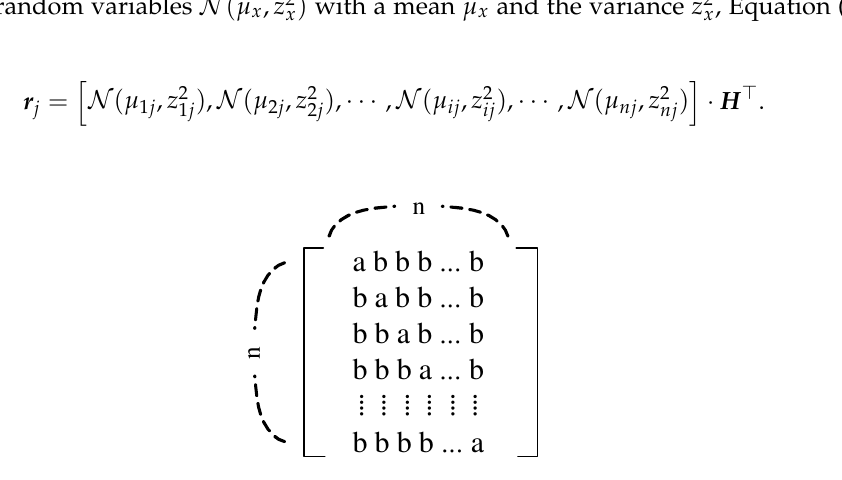
Figure 3. Circulant matrix for constructing multi-level H